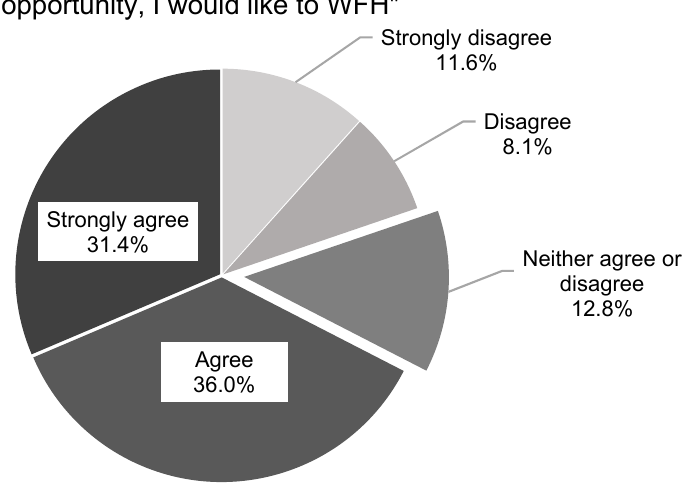
Figure 7. Future preference for WFH after the pandemic.